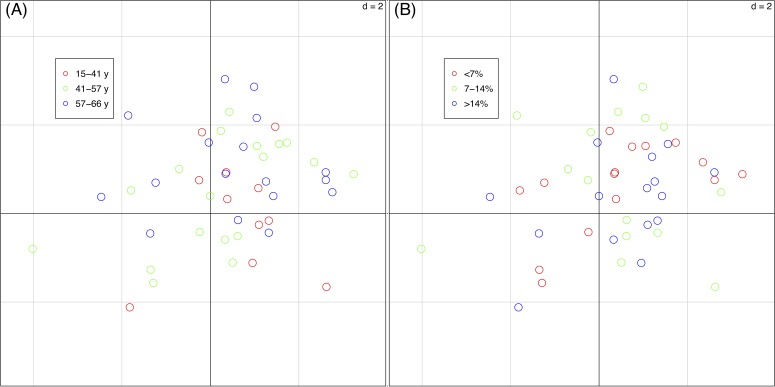
Sample scores (46 vegetation plots) of the first two axes of the basic-RLQ.The colours show the terrain age (A) and the cobble cover (B) classes of the sample plots. The eigenvalues are reported in Table 4. The values of d give the grid size.